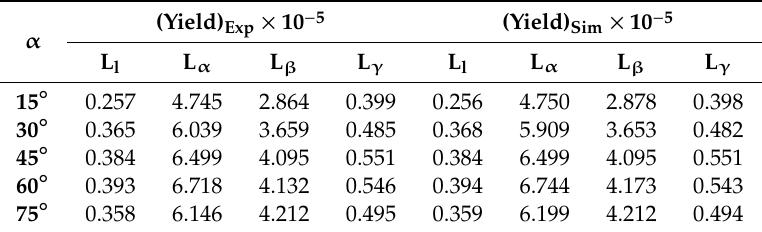
Table 1. Measured and simulation results for L l , L α , L β and L γ X-ray photon yields (photons electron − 1 ,